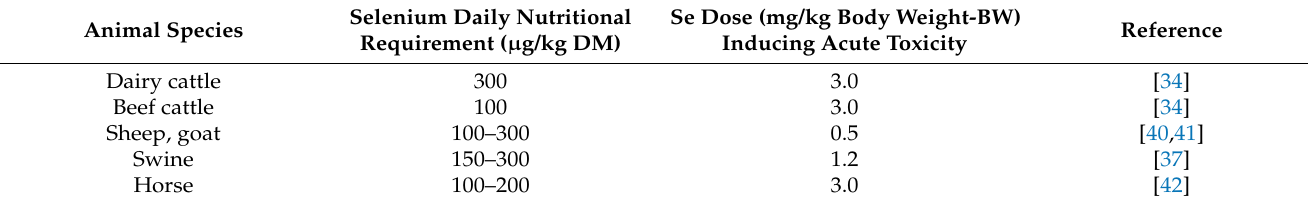
Table 1. Selenium daily nutritional requirement (supranutritional) and acute toxic levels in various animal species.